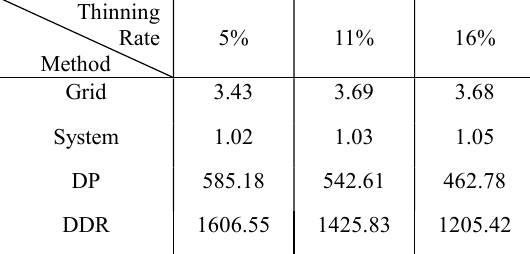
Table 4. Experimental time (second)